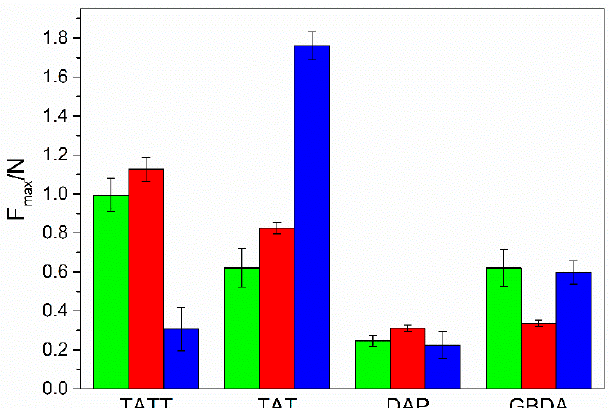
Figure 7. Puncture resistance for investigated ionogels obtained by photopolymerization of thiols TMPTP (green columns), PETMP (red columns), and PETMB (blue columns) with different allyl monomers: TATT, TAT, GBDA, and DAP.